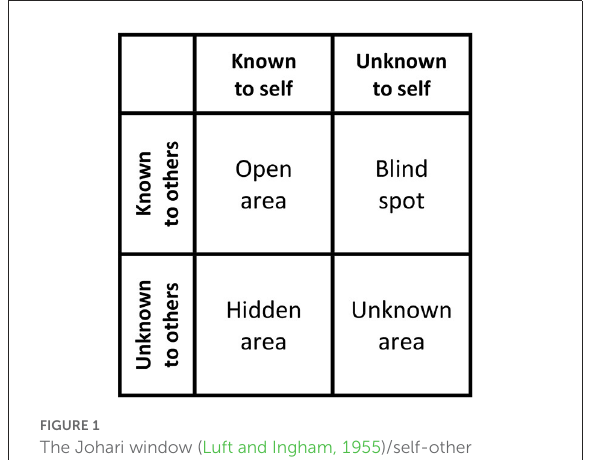
FIGURE1 The Johari window (Luft and Ingham, 1955)/self-other knowledge asymmetry model (Vazire,